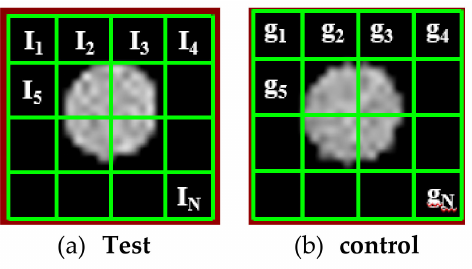
Figure 1. Illustration of the reflectivity calculation using ( a ) the segmented image from the test sample MRI and ( b ) the segmented area of the control sample MRI image.